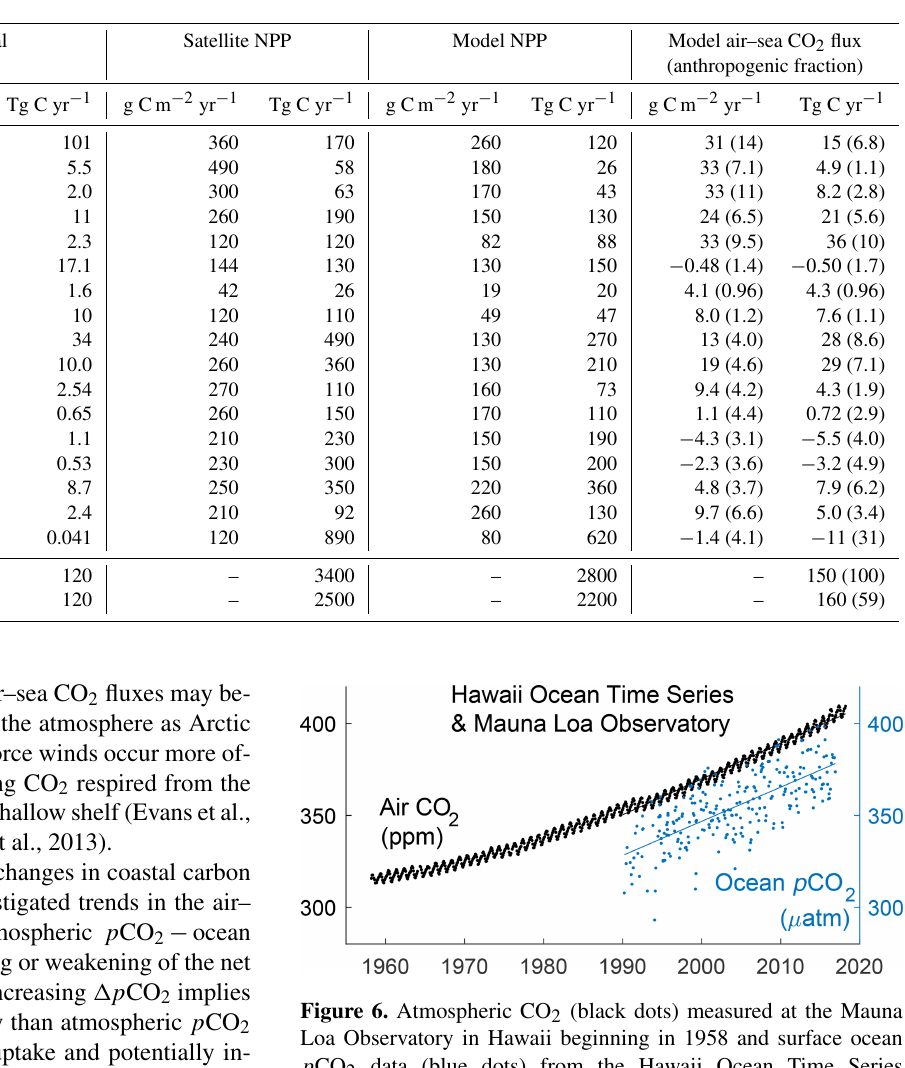
Table 2. Estimates of satellite-derived carbon burial and primary production (NPP) from Dunne et al. (2007) and model-simulated NPP and air–sea CO 2 flux from Bourgeois et al. (2016) for a decomposition of the EEZ of Canada, the US, and Mexico. Model estimates are calculated by averaging the years 1993–2012. Positive numbers represent fluxes into the coastal ocean. Subregion abbreviations are given in the caption of Fig. 4.